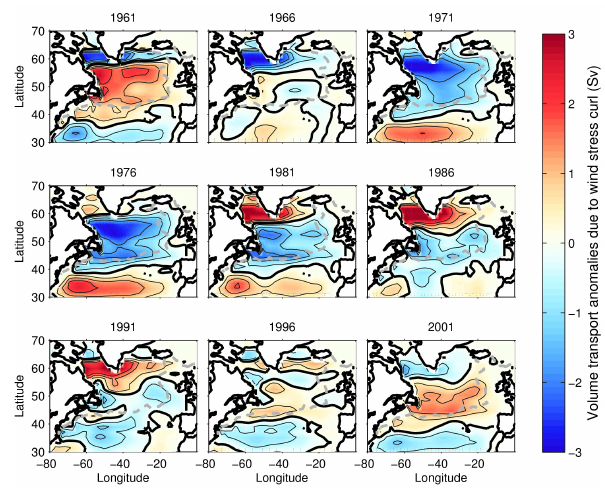
Figure 8. As Fig. 6 but for transport anomalies derived from the Sverdrup relation (Sv). Fig. 8. As Fig. 6 but for transport anomalies derived from the Sver- drup relation